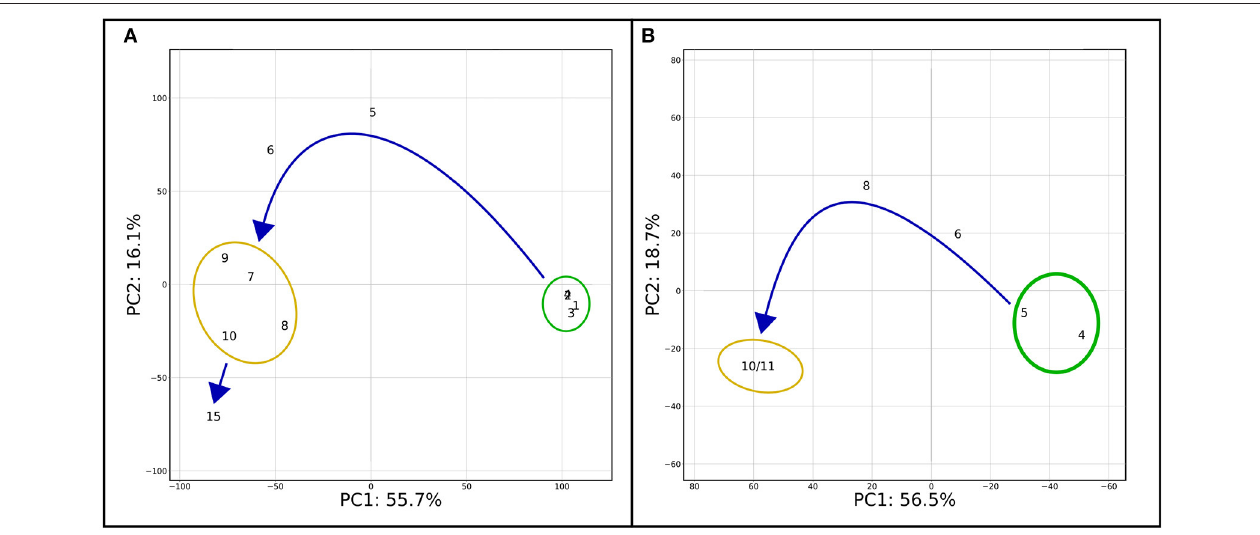
FIGURE 3 | PCA on transcriptomic and metabolomic results. (A) PCA was performed on the significantly differentially expressed genes (|log2FC| ≥ 1). The first two components of the PCA explained 71.8% of the variance. (B) PCA performed on metabolites metabolite abundance compared to the control (before DRNS) during the time course of the experiment. Only metabolites which change is significant (|log2FC| ≥ 2) in at least one of the time points were considered for the analysis. As for Figure 1A , two major groups are delimited: NRep (green) and NS (yellow) with a transition phase in between. Differently from Figure 1A , day 15 has been considered as separate point and not together with the NS group.